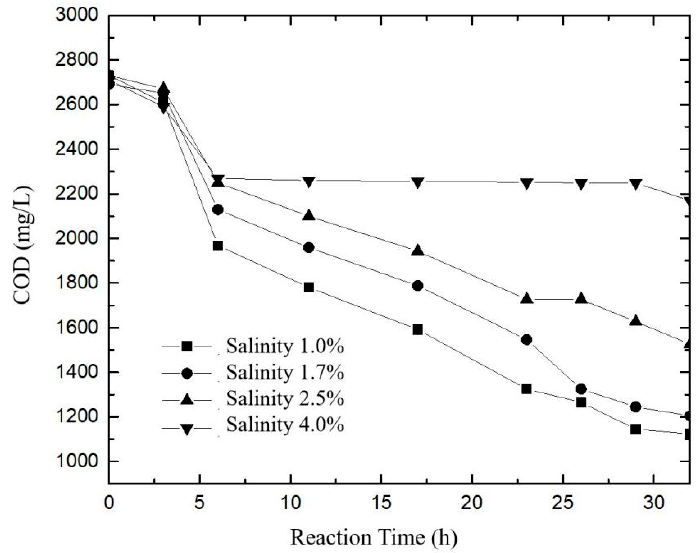
Figure 6. COD changes under different salinity.